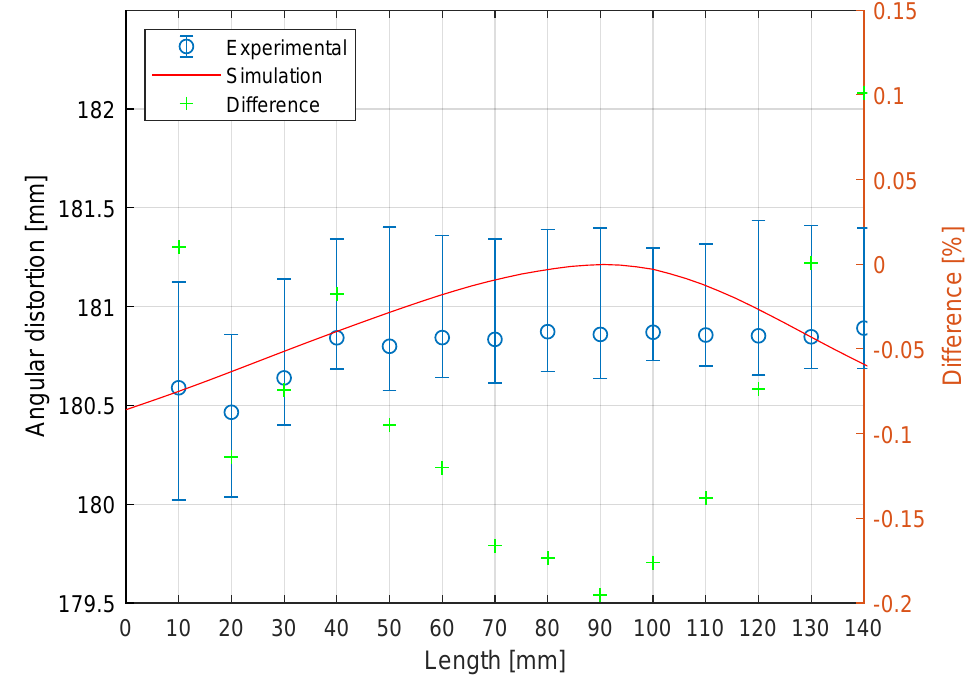
Figure 8. Predicted results against experimental results.